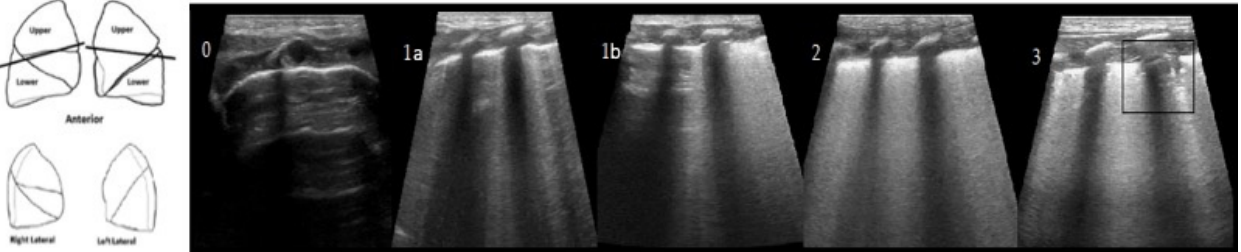
Figure 2. The lung ultrasonography score (nLUS). Lungs are divided into three areas: upper anterior; lower anterior; lateral. Each area is scored. Score values are related to the patterns that are shown in the upper part of the figure. Scores is given as follows: 0, only A-lines; 1, presence at least 3 B-lines or A-lines in the upper part of the lung, coalescent B-lines in the lower part of the lung; 2, coalescent B lines with or without consolidations limited to sub-pleural space; 3, extended consoli- dation.